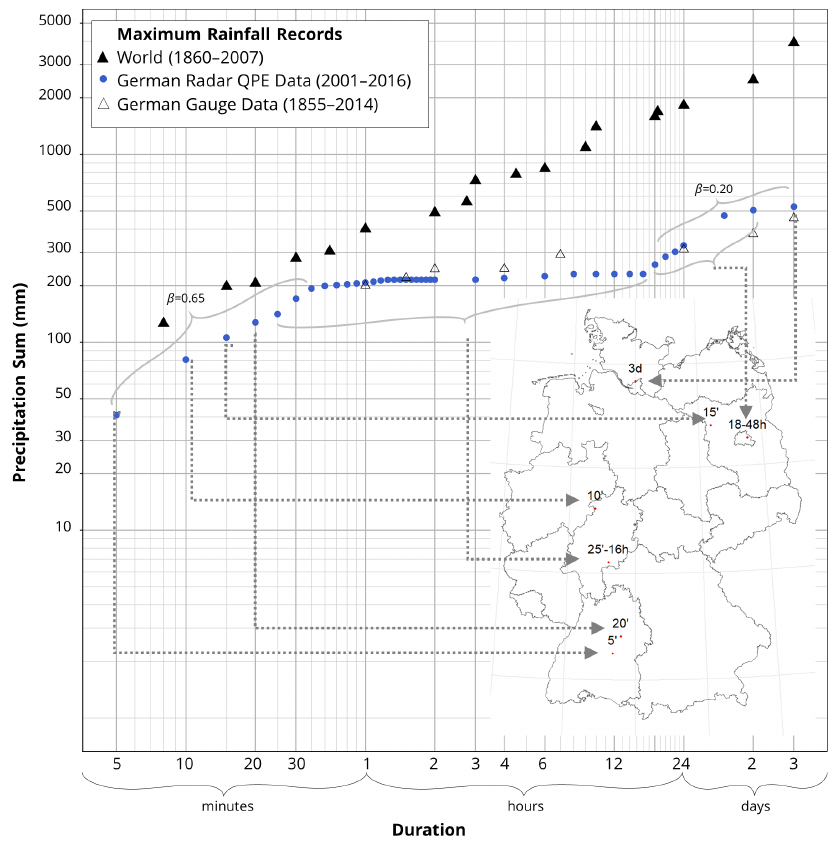
Figure 3. Overview of maximum rainfall records in Germany. Chart: maximum depth–duration relationship of rainfall records based on QPE RADKLIM-YW (data of this study) (blue dots) and as reference the relationships based on the German ground network (Rudolf and Rapp, 2003; DWA, 2015; DWD, 2020) (non-filled triangles) and the global precipitation extremes (World Meteorological Organization, 1994; NWS, 2017). Map: locations of rainfall maxima (based on QPE RADKLIM-YW) for the considered duration. Table 1. Rainfall records for different duration from RADKLIM-YW for 2001–2016 with corresponding locations. Duration Start date Start time Precipitation Location (CET) sum (mm) (WGS84) 5min 4 Jul 2009